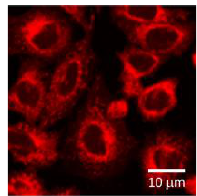
Figure 33. Synthesis of PM1 and PM6 derivatives presenting G-quadruplex stabilization and antiproliferase activity with a red emission in mitochondria. Reprinted with permission from reference [151]. Copyright 2021 Elsevier.